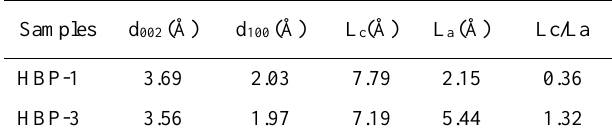
Table 3. XRD parameter of activated carbon monolith derived